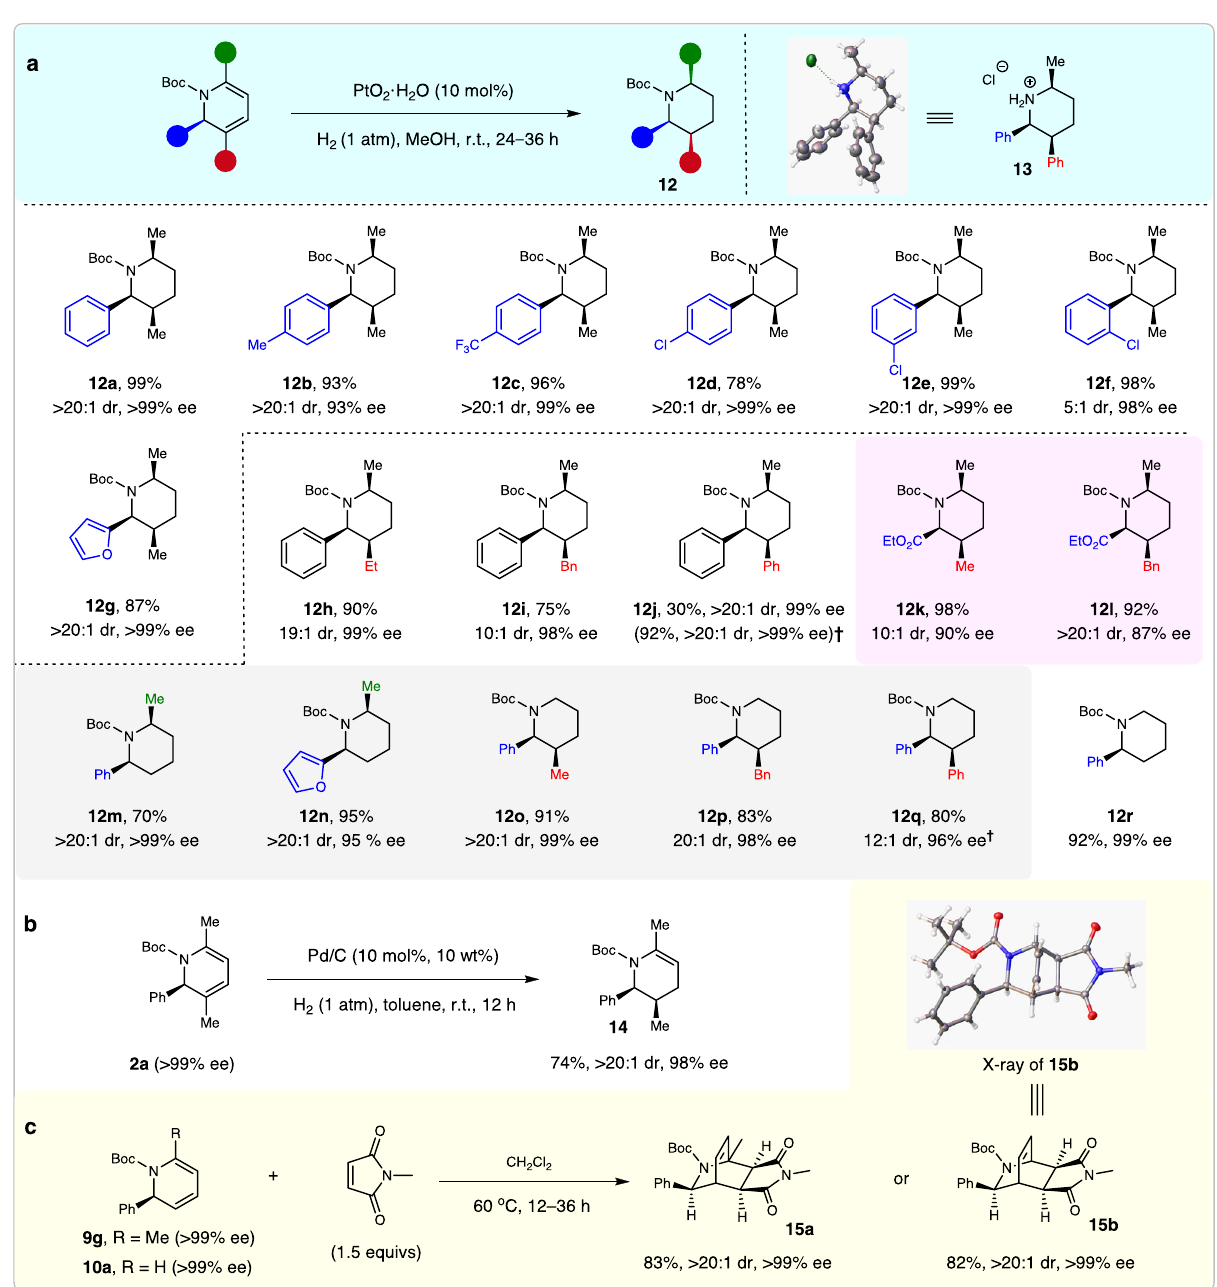
Fig. 4 Synthetic utility. a Diverse synthesis of cis -polysubstituted chiral piperidines 12 . b Synthesis of chiral tetrahydropyridine 14 . c Diels-Alder reaction to bridged rings 15 . † Using Pd/C instead of PtO 2 ·H 2